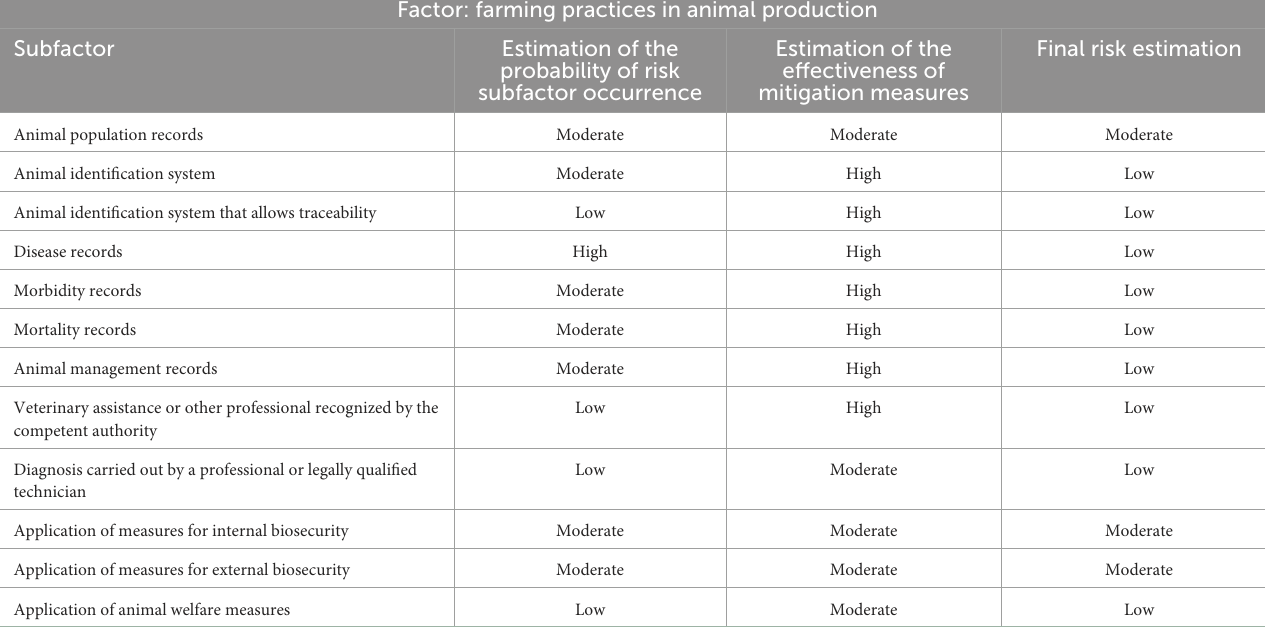
TABLE 7 Example ∗ of a qualitative risk assessment for farming practices in animal